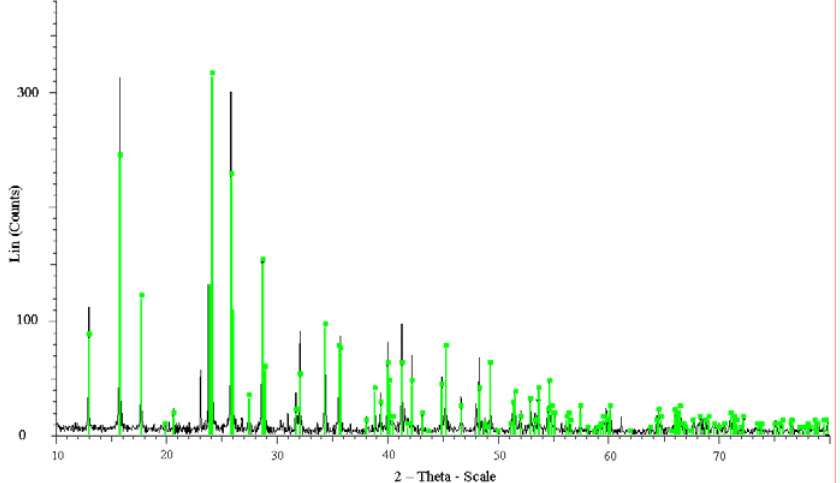
Fig. 4 X-ray diffraction pattern of sample LaP 3 O 9